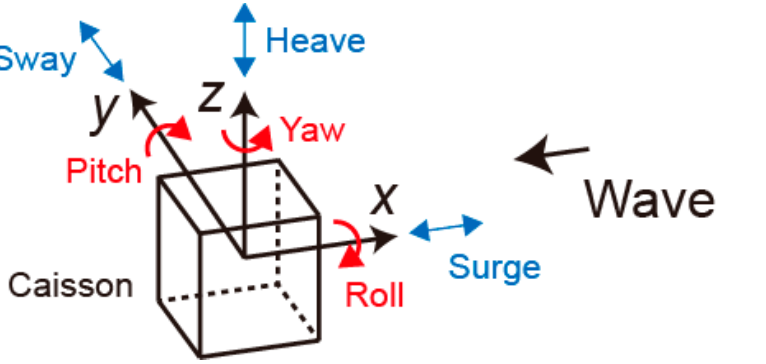
Figure 3. Definition of the six degree ‐ of ‐ freedom (DOF) motion.